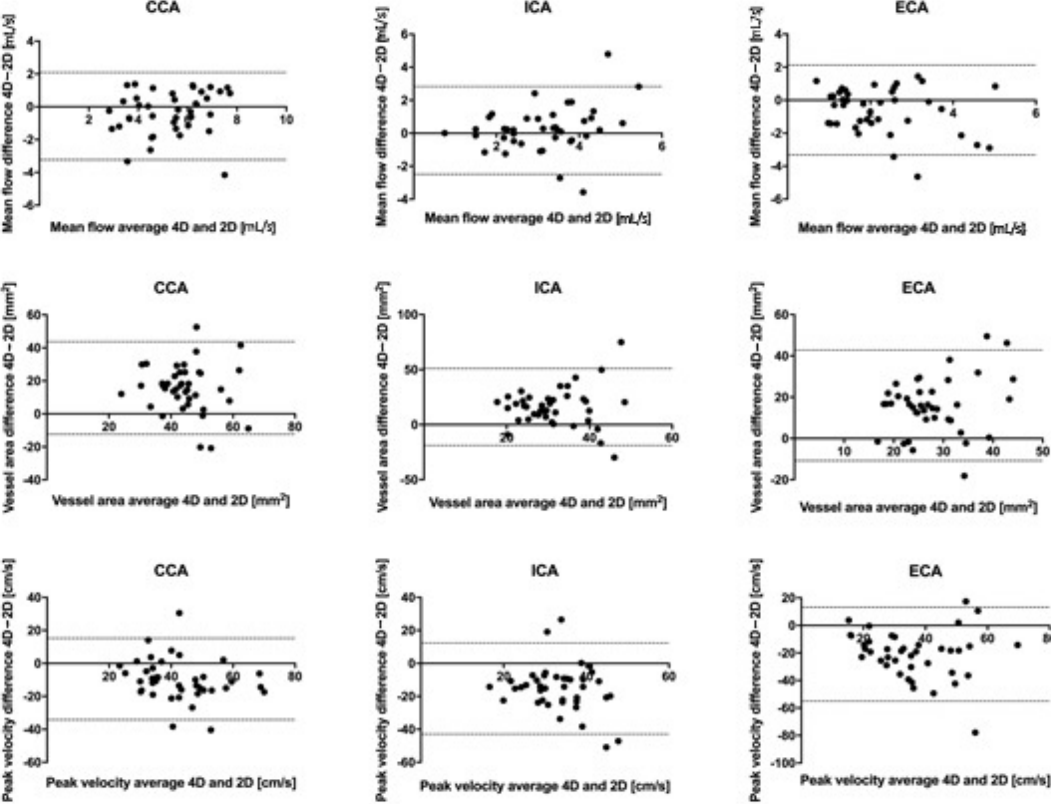
Figure 3. Bland-Altman plots of 4D-flow in all the carotid branches compared against 2D phase contrast. Dashed lines indicate the limits of agreement (±1.96 SD).